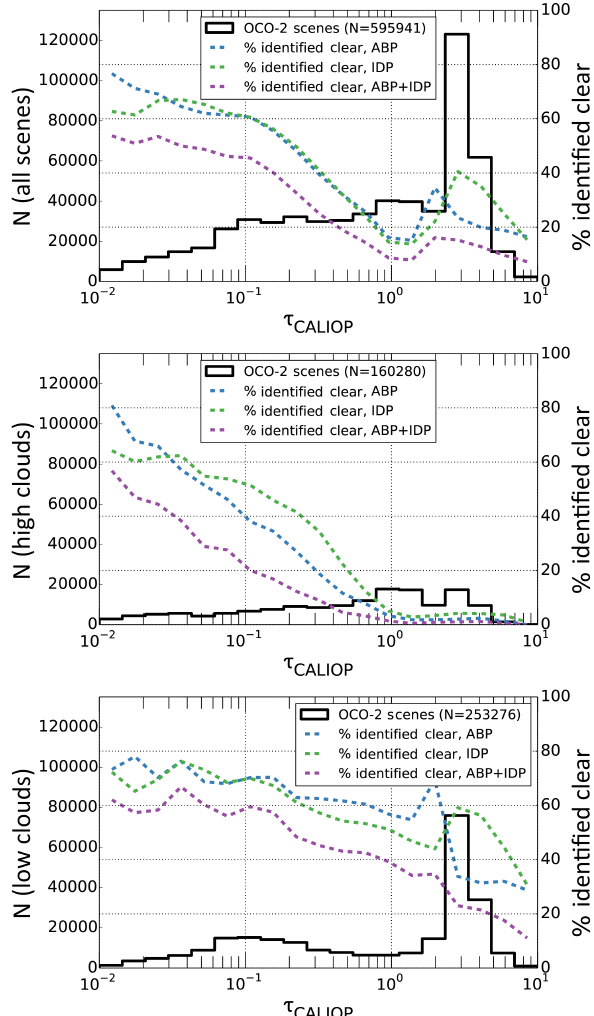
Figure 7. Comparison of OCO-2 cloud screening to CALIOP opti- cal depth measurements for collocated soundings. Histograms of the number of OCO-2 soundings are shown as black solid trace against the left ordinate, and percent of soundings identified as clear versus the CALIPSO optical depth are shown against the right ordi- nate. Only the May nadir-land viewing data were used. Each panel shows results for the combined ABP + IDP (pink), the ABP only (blue) and IDP only (green). The top panel uses the total number of scenes, while the middle and lower panel use only the high-cloud and low-cloud scenes, respectively, where high and low clouds are defined in the